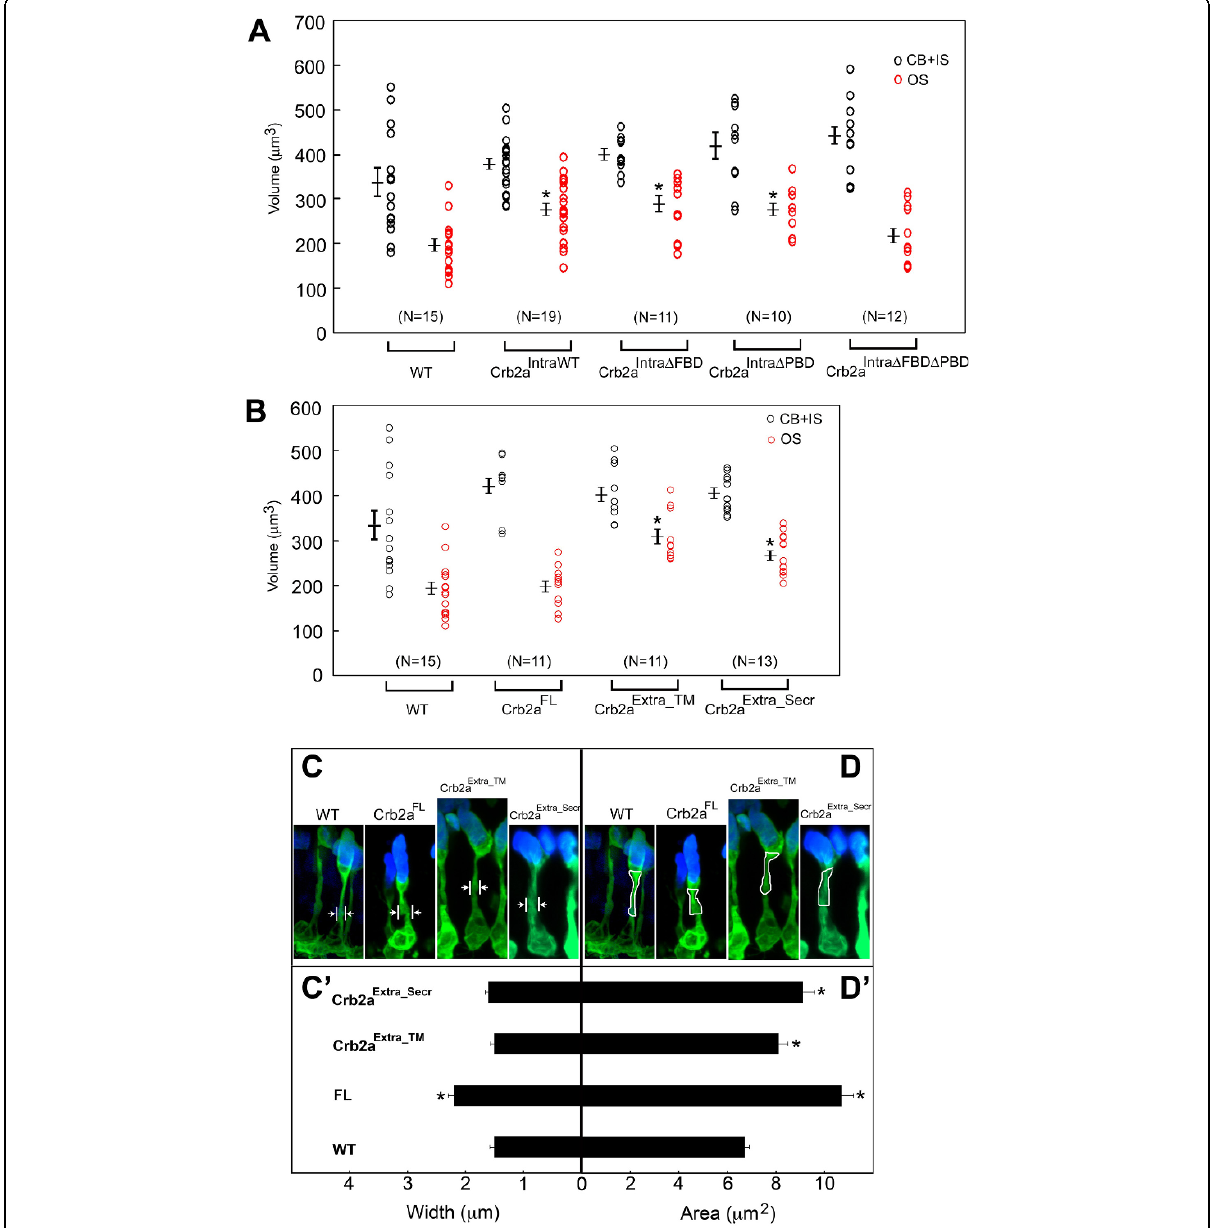
Figure 4 Measurement of rod size in Crb2a transgenics . (A) The average combined volume of rod cell body and inner segment (black circles) measured 332 ± 30 μ m 3 (wildtype), 372 ± 13.6 μ m 3 (Crb2a IntraWT ), 394 ± 12.2 μ m 3 (Crb2a Intra Δ FBD ), 416 ± 28.9 μ m 3 (Crb2a Intra Δ PBD ), and 436 ± 22.8 μ m 3 (Crb2a Intra Δ FBD Δ PBD ). The average volume of a rod outer segment (red circles) measured 190 ± 15.7 μ m 3 (wildtypes), 277 ± 15.4 μ m 3 (Crb2a IntraWT ), 283 ± 20.6 μ m 3 (Crb2a Intra Δ FBD ), 278 ± 15.9 μ m 3 (Crb2a Intra Δ PBD ), and 212 ± 18.9 μ m 3 (Crb2a Intra Δ FBD Δ PBD ). (B) The average combined volume of rod cell body and inner segment (black circles) measured 332 ± 30 μ m 3 (wildtype), 426 ± 17.5 μ m 3 (Crb2a FL ), 401 ± 17.8 μ m 3 (Crb2a Extra_TM ), and 405 ± 11 μ m 3 (Crb2a Extra_Secr ). The average volume of a rod outer segment (red circles) measured 190 ± 15.7 μ m 3 (wildtype), 198 ± 13.8 μ m 3 (Crb2a FL ), 316 ± 17.2 μ m 3 (Crb2a Extra_TM ), and 268 ± 12.1 μ m 3 (Crb2a Extra_Secr ). (C, C ’ ) Width of the inner segment myoid region was marked as in (C) and the measurements are shown in (C ’ ). The width of the myoid region is significantly larger in Crb2a FL rods (2.2 ± 0.1 μ m) than wildtypes (1.5 ± 0.08 μ m). Crb2a Extra_TM (1.5 ± 0.07 μ m) and Crb2a Extra_Secr (1.6 ± 0.06 μ m) are similar to wildtypes. (D, D ’ ) Area of the myoid region was outlined as in (D) and the measurements are shown in (D ’ ). The area of the myoid region is significantly larger in Crb2a FL (10.7 ± 0.5 μ m 2 ), Crb2a Extra_TM (8.1 ± 0.4 μ m 2 ), and Crb2a Extra_Secr (9.1 ± 0.5 μ m 2 ) compared to wildtypes (6.7 ± 0.2 μ m 2 ). Each circle represents a measurement of a single rod. Shown values are mean ± s.e.m, *, p < 0.005, student ’ s t